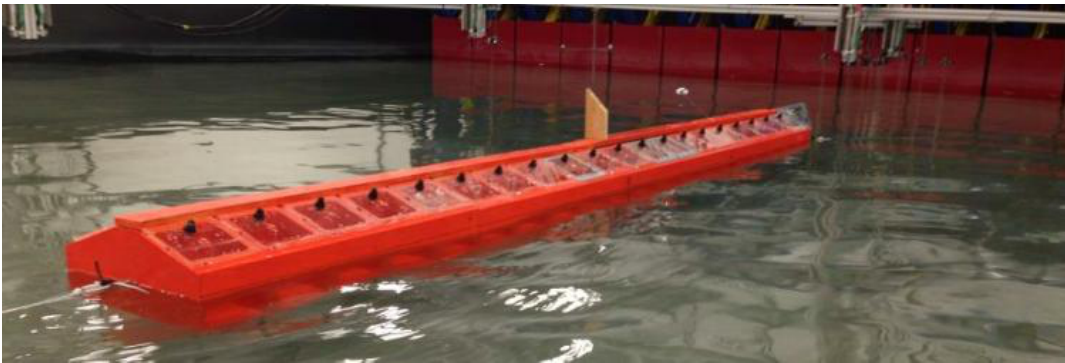
Figure 2. The 3-meter experimental model of the KNSWING.